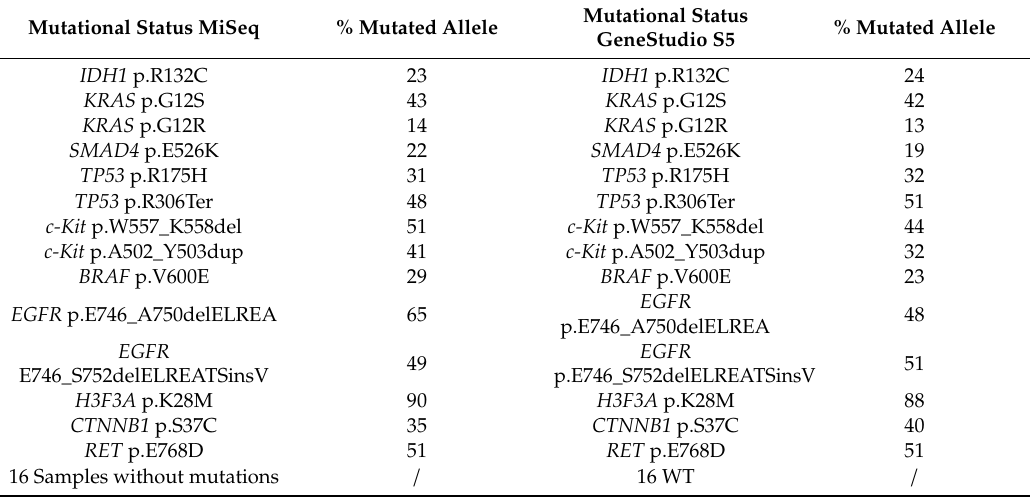
Table 2. Custom-designed multi-gene panel analytical validation of 30 samples using MiSeq and GeneStudio S5.